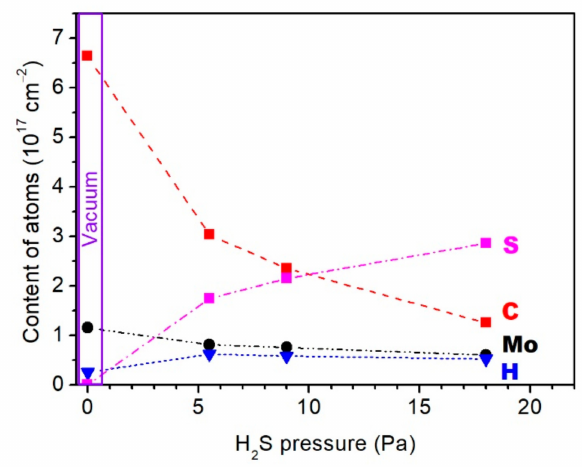
Figure 2. Influence of hydrogen sulfide pressure on the composition of Mo-S-C-H films which were obtained by pulsed laser codeposition of carbon and molybdenum in 20